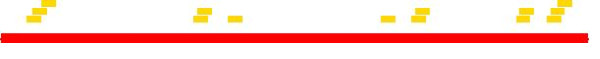
Schematics of zinc finger nucleases cleaving HPV type 18 genomic DNA. This figure offers a diagrammatic illustration of loci of action of zinc finger nucleases that target and cleave >18 bp (9x2 + 5, 6, or 7) sequences within the genomic DNA context of HPV type 18. Hits (blue, green, and gold bars) represent targets along the gene (red bars). ZFN hits in the graphic are color-coded on the basis of spacer size (5 bp = Blue; 6 bp = Green; 7 bp = Gold).